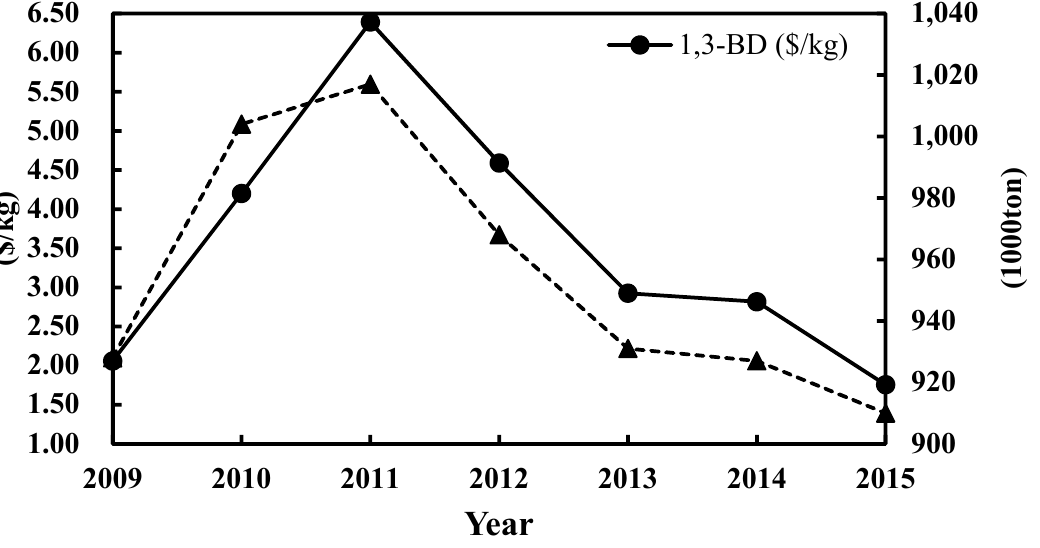
Figure 7. The price of 1,3-BD and the consumption of automobile tires (2009–2015) [22].